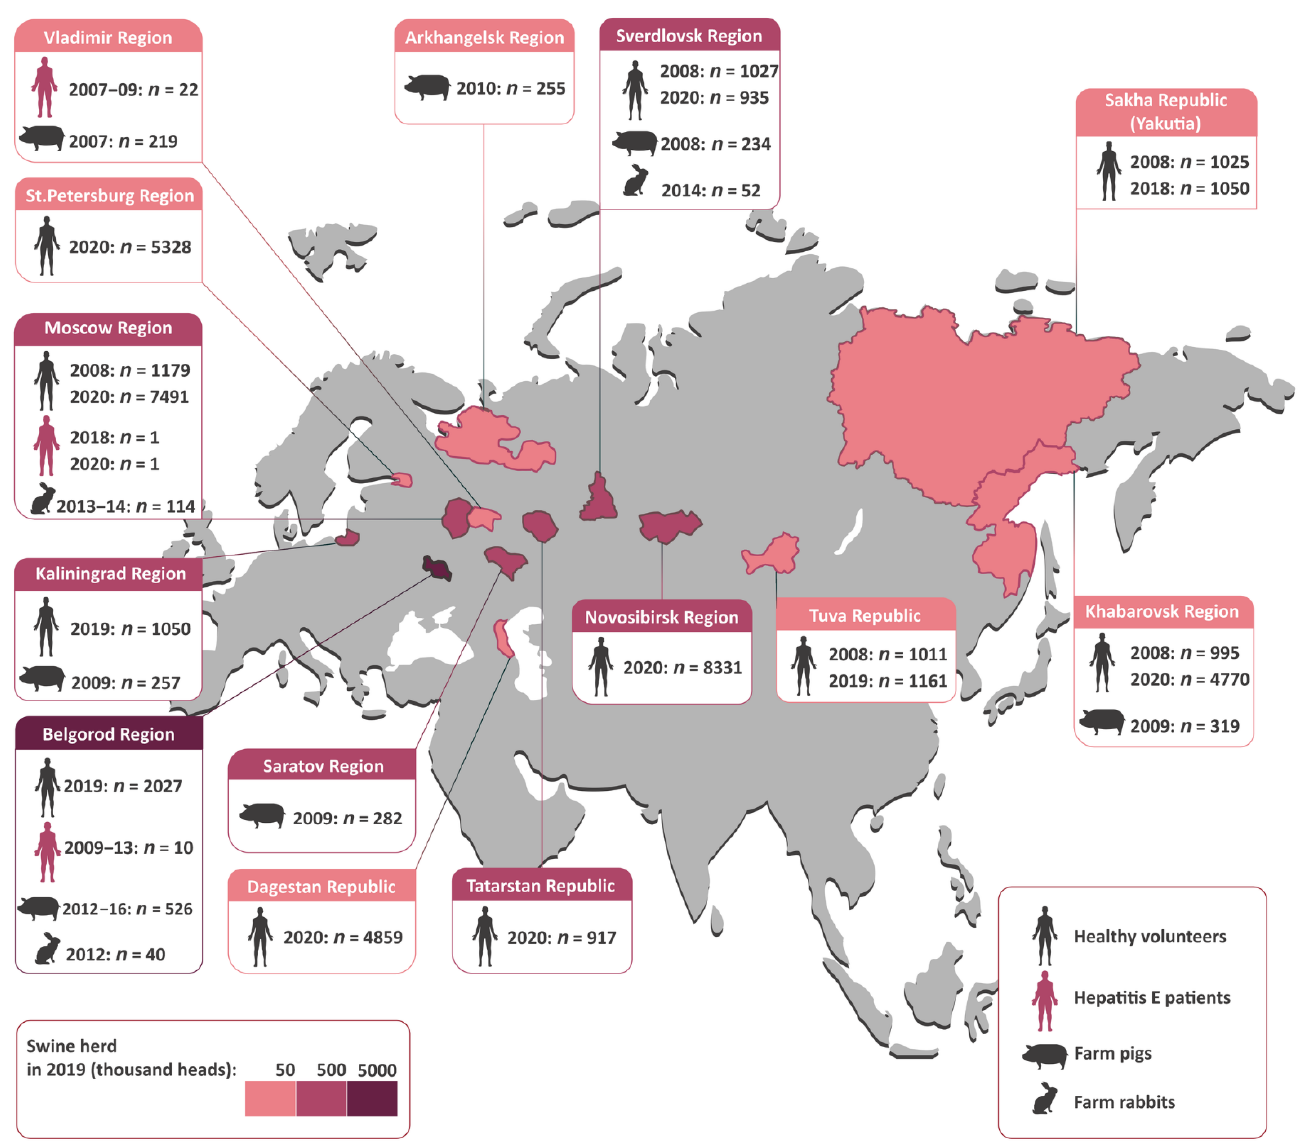
Figure 1. The study regions (in pink) shown on a map of Russia alongside the numbers and sources of the samples collected in each region. The colored bar represents the population of farm pigs (in thousand heads) in each study region based on a federal state statistical report from 2019 [16].